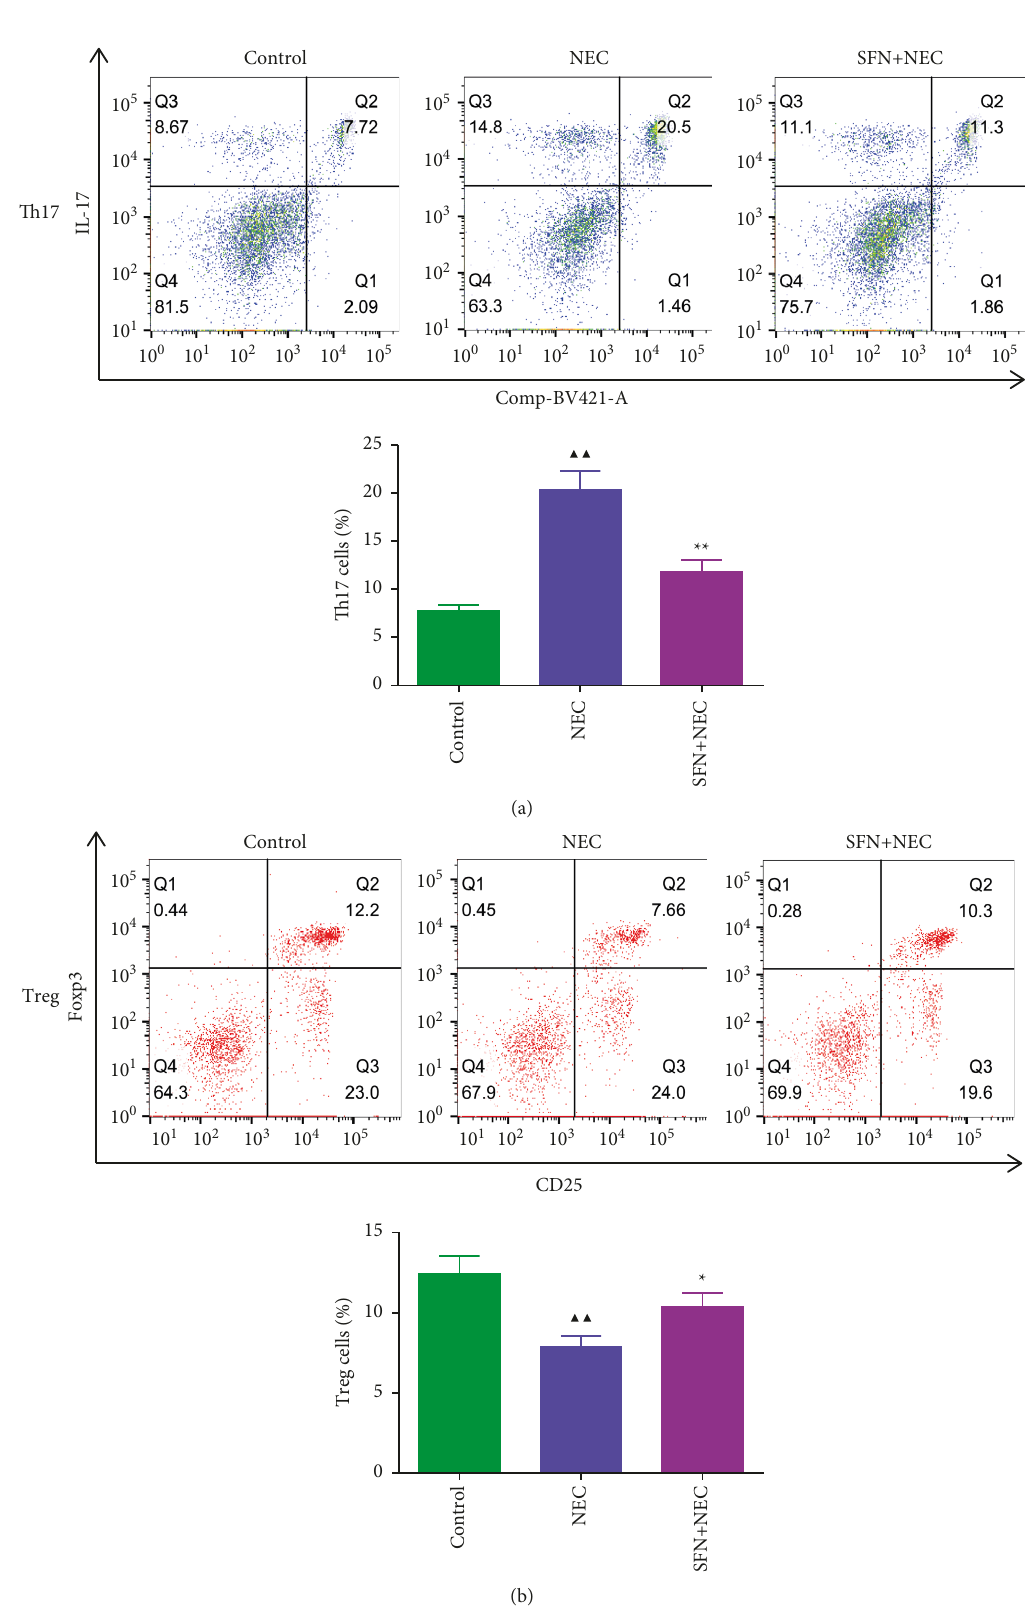
Figure 3: Changes in the proportion of Th17 and Treg cells in intestinal tissues of mice. NEC, necrotizing enterocolitis; SFN, sulforaphane. Compared with the control group, ▲ P < 0 . 05, ▲▲ P < 0 . 01; compared with the NEC group, ★ P < 0 . 05, ★★ P < 0 . 01. Data represent the mean ± SD, n �